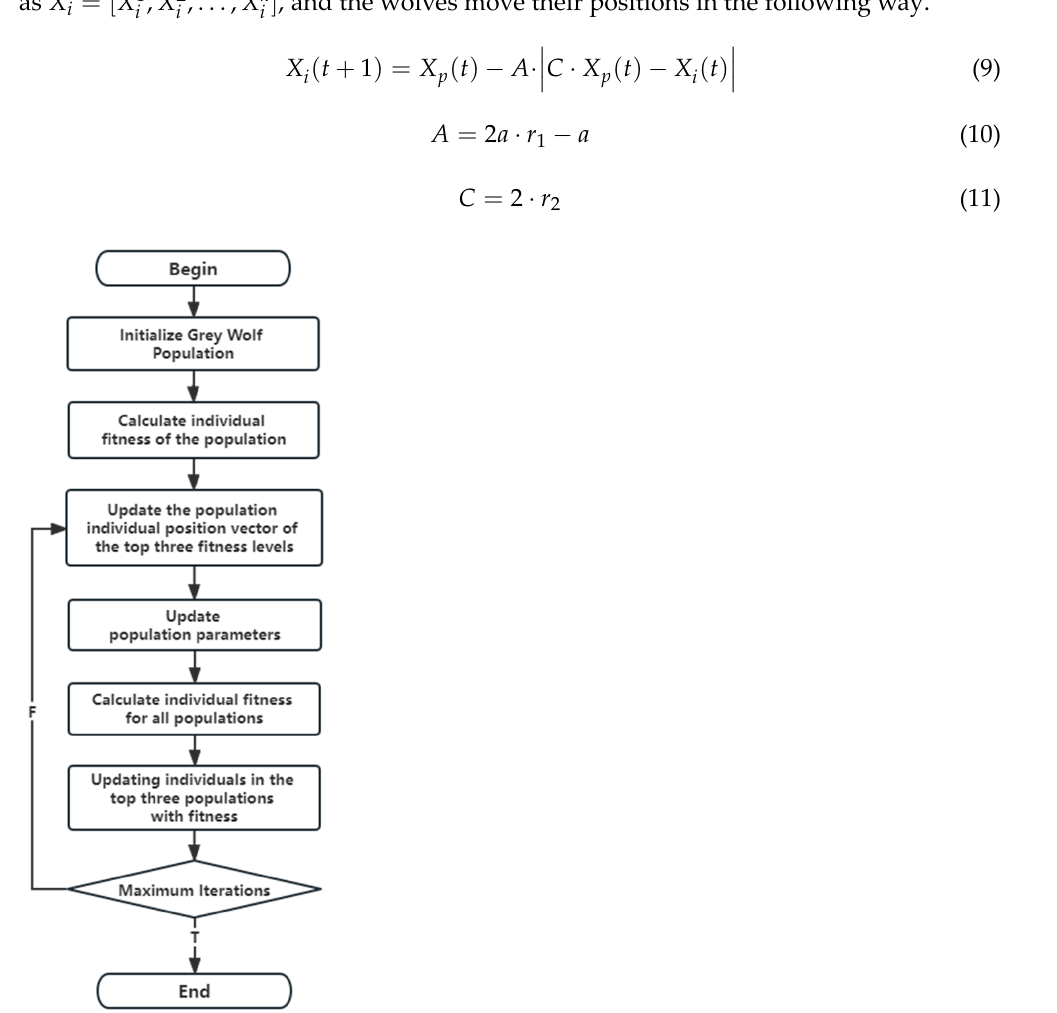
Figure 1. GWO algorithm fl ow chart.